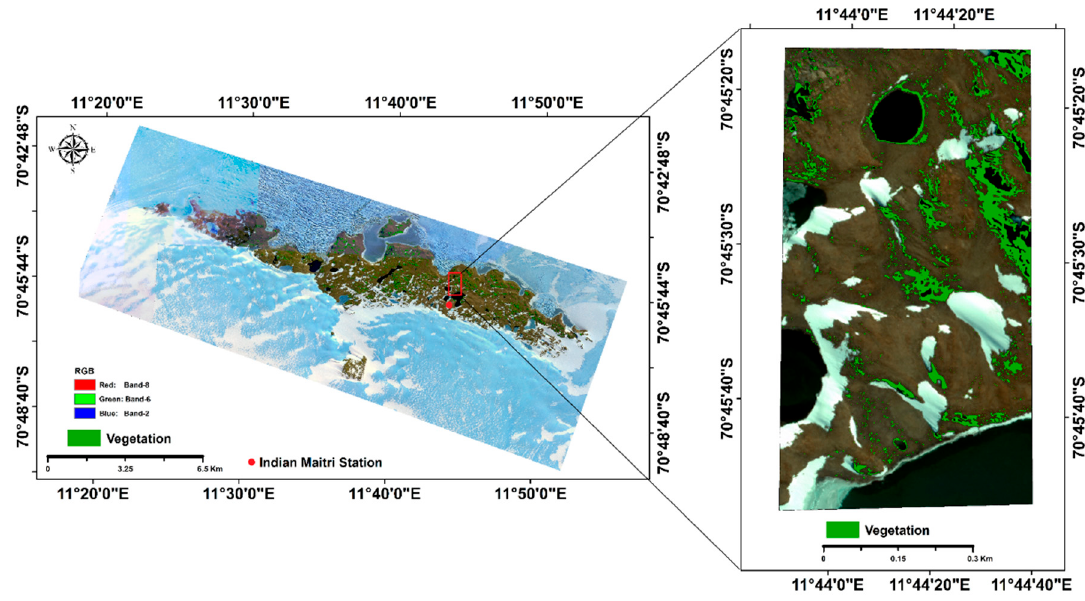
Figure 11. The vegetation cover map of Schirmacher Oasis and environs derived using ensemble (winner-takes-all/majority consensus) merging of the five top-performing methods [Mixture Tuned Matched Filtering (MTMF), Matched Filtering/Spectral Angle Mapper ratio (MF/SAM), Matched Filtering (MF), normalized difference vegetative index (NDVI)-2, and NDVI-4)]. Map prepared using WV-2 satellite image [(Band 8 (860–1040 nm), Band 6 (705–745 nm), Band 2 (450–510 nm)].